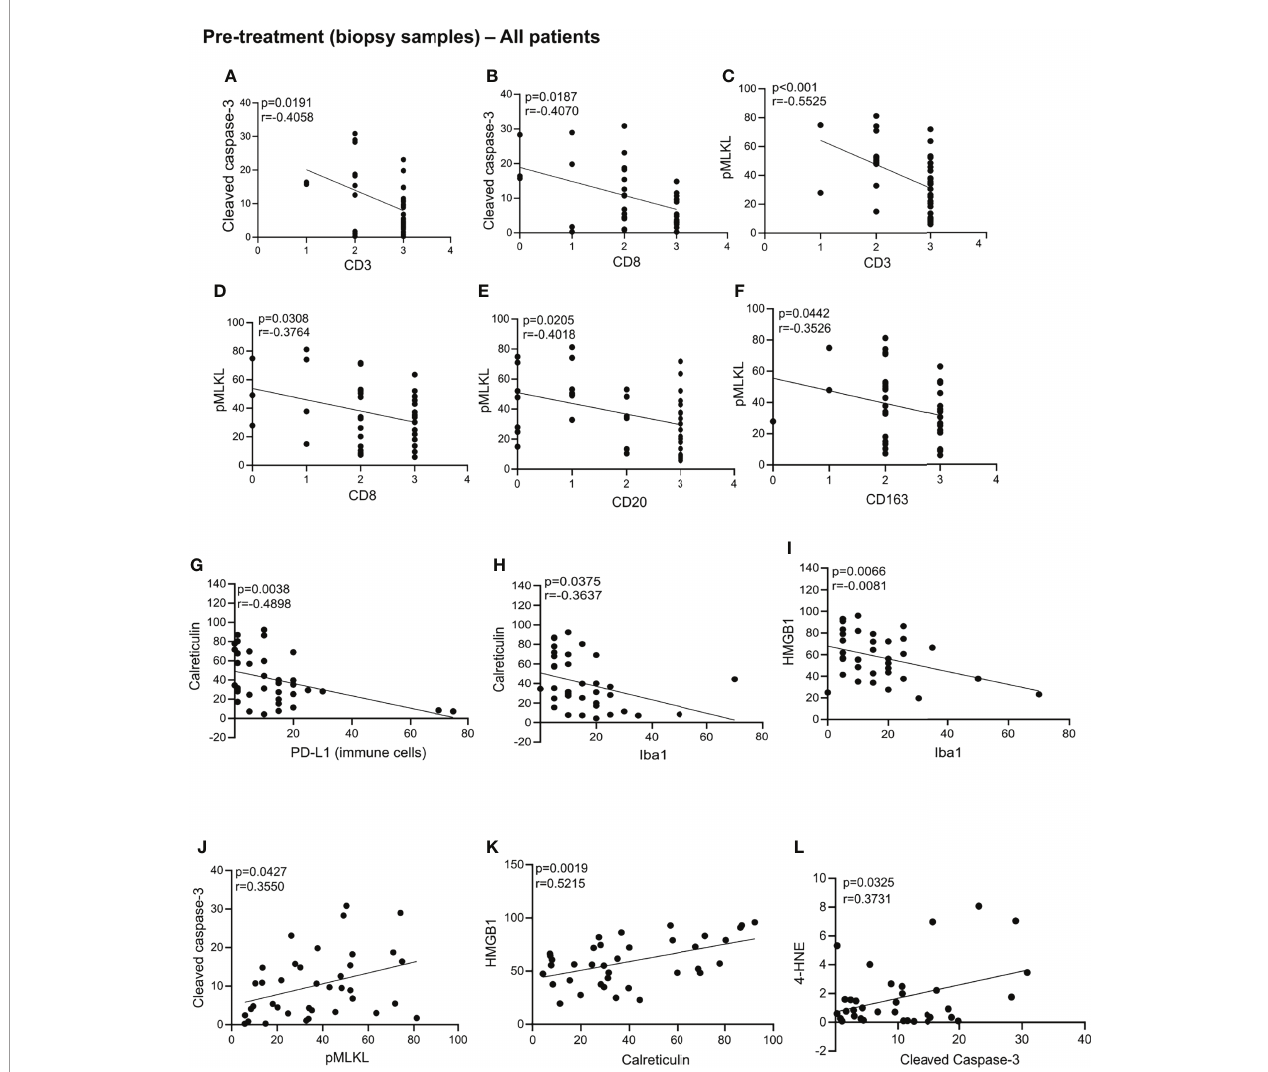
FIGURE 3 | Statistically signi fi cant correlation in the biopsy samples. Statistically signi fi cant correlations were found between cleaved caspase-3 and CD3 (A) , CD8 (B) , CD3 (C) , CD8 (D) , CD20 (E) , CD163 (F) ; calreticulin and PD-L1 (G) and Iba1 (H) ; HMGB1 and Iba1 (I) ; cleaved caspase-3 and pMLK (J) ; HMGB1 and calreticulin (K) ; 4-HNE and cleaved caspase-3 (L) . All p-values and correlation coef fi cients were evaluated with two-sided test of correlation (Genstat 64-bit Release 20.1) are indicated on the graphics which were generated with GraphPad (version